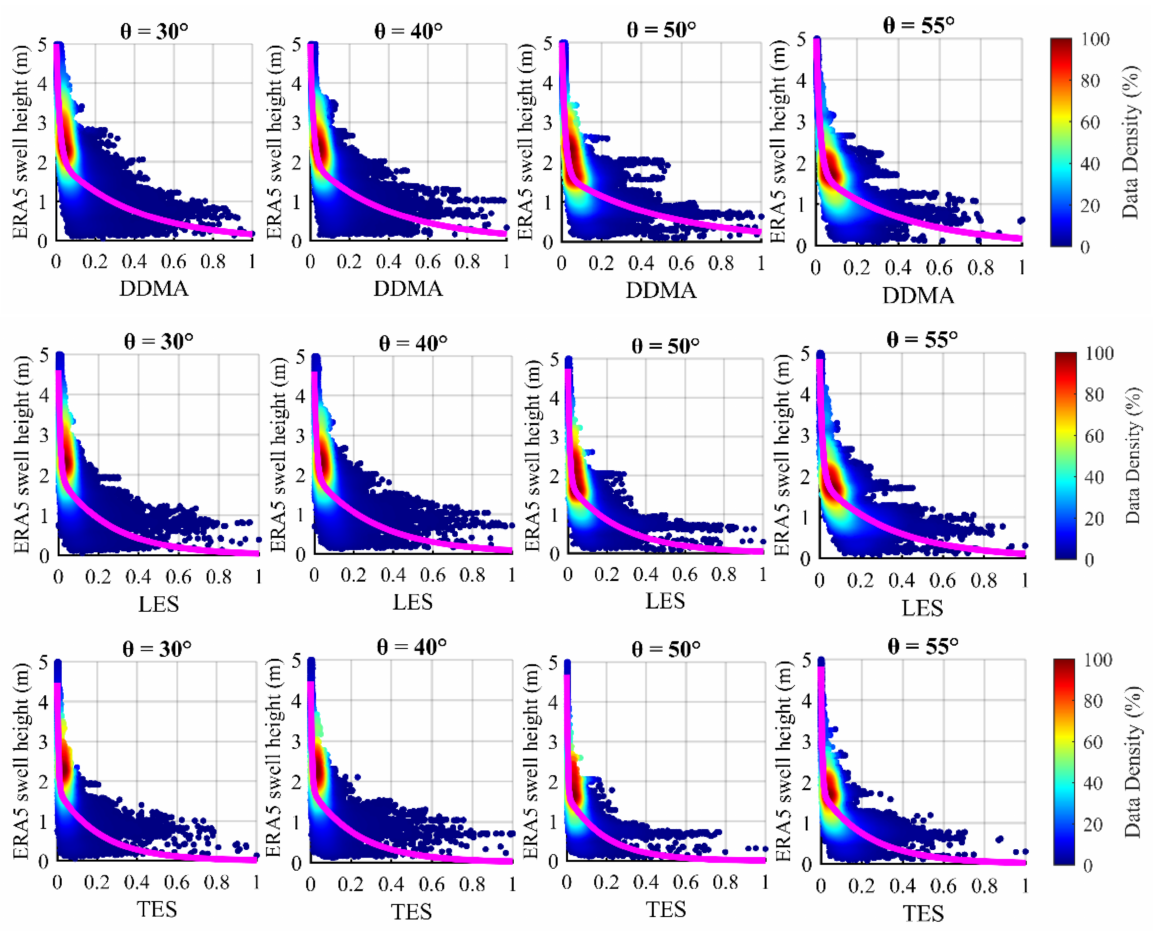
Figure 5. Scatter density plots of DDMA ( top ), LES ( middle ), and TES ( bottom ) calculated by DDM compared to ground truth ERA5 swell height at incidence angles of 30 ◦ , 40 ◦ , 50 ◦ , and 55 ◦ (left to right). Magenta solid line represents swell height fitting model. The colors indicate data density related to the distribution peak.